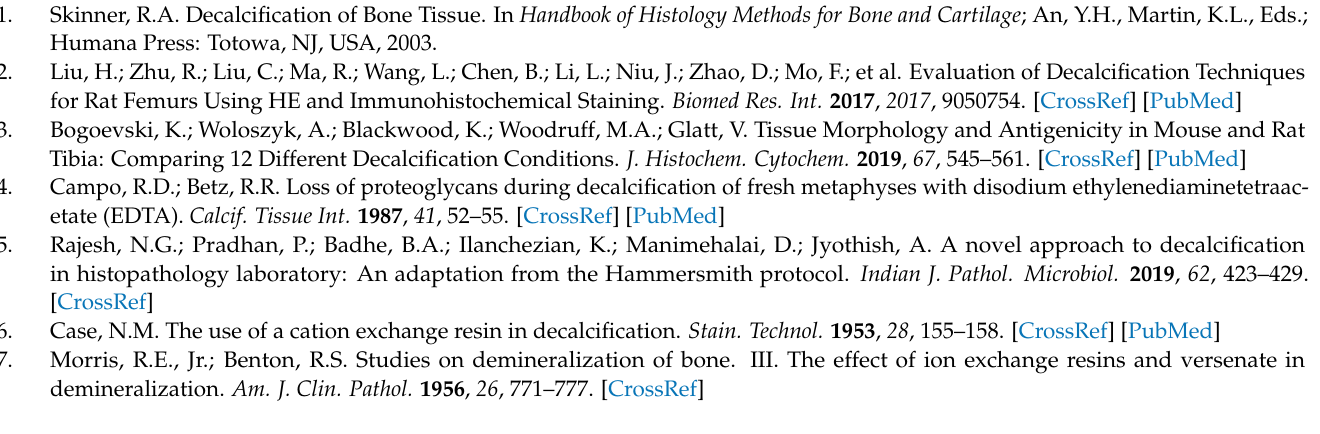
Table S1: Arduino sketch; Table S2: Modified hematoxylin and eosin